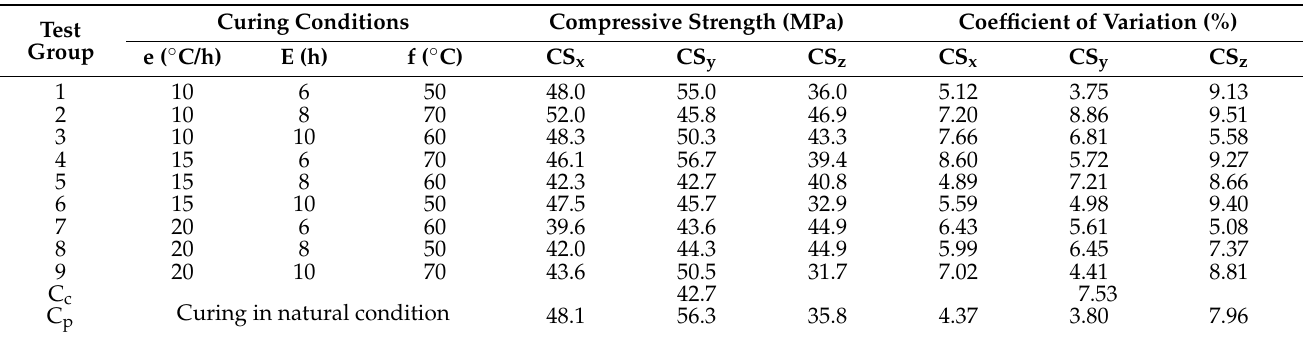
Table 5. Orthogonal experimental table of various test group designs, curing conditions, compressive strength test data, and coefficients of variation.